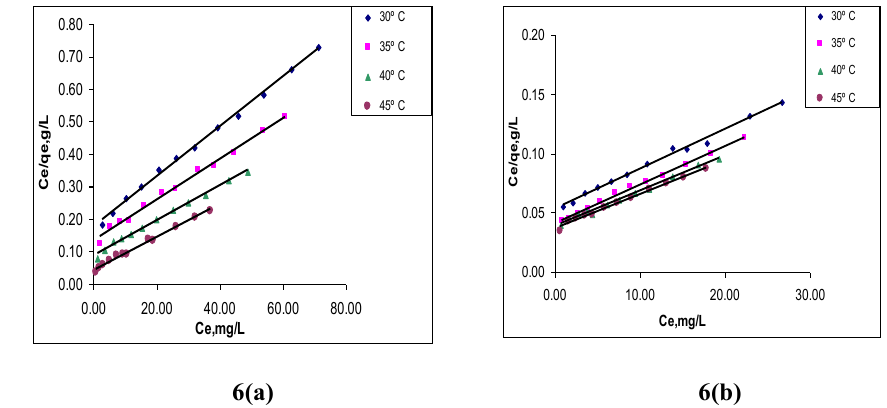
Figure 6. Langmuir adsorption isotherm plots for the adsorption of DB 71 dye onto TPAC and PPC (adsorbent dosage, 100mg; pH, 4.3; agitation time, 120 min).